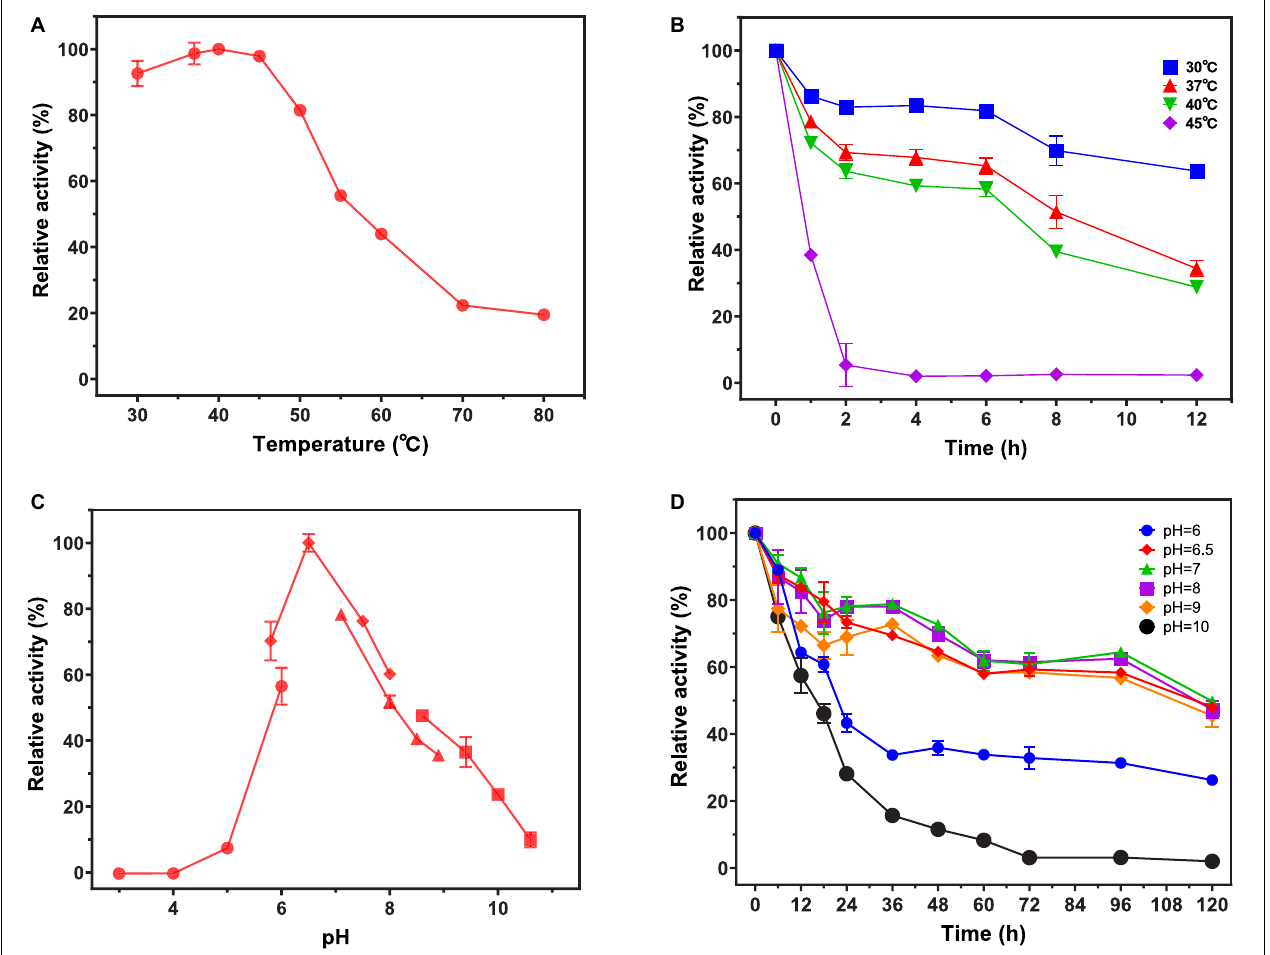
FIGURE 3 | Effect of pH and temperature on the activity and stability of NAGaseA. (A) The optimal temperature of the recombinant NAGaseA. The temperature optimum was determined at different temperatures (30–80 ◦ C) in 50 mM phosphate buffer (pH 6.5). (B) The temperature stability of the recombinant NAGaseA. To determine the temperature stability, the enzyme was incubated in 50 mM sodium citrate (pH 6.5) for 12 h at different temperatures, the residual activity was measured at pH 6.5 and 40 ◦ C. (C) The optimal pH of the recombinant NAGaseA. The optimal pH was determined in 50 mM solutions of various buffers within the pH range 3–11. ( (cid:108) Citrate buffer (pH 3.0–6.0), (cid:117) Phosphate buffer (pH (6.0–8.0), (cid:115) Tris-HCl buffer (pH 7.0–9.0), (cid:110) Glycine-NaOH buffer (pH 8.5–10.5)). (D) The pH stability of the recombinant NAGaseA. To determine the pH stability, the enzyme was incubated with various pH buffers, and the residual activities were measured ( (cid:108) Citrate buffer (pH 6.0), (cid:117) Phosphate buffer (pH 6.5), (cid:115) Phosphate buffer (pH 7.0), (cid:110) Phosphate buffer (pH 8), (cid:117) Glycine-NaOH buffer (pH 9), (cid:108) Glycine-NaOH buffer (pH